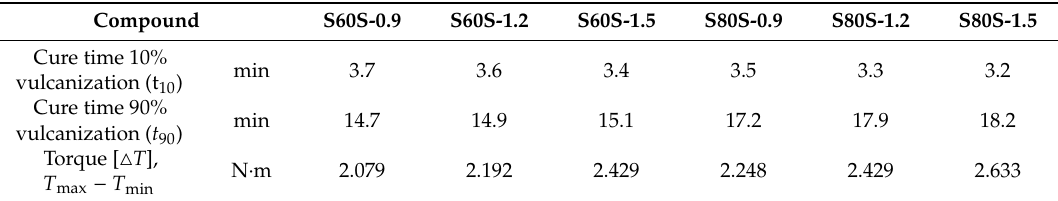
Table 3. Cure characteristics of vulcanizates by sulfur